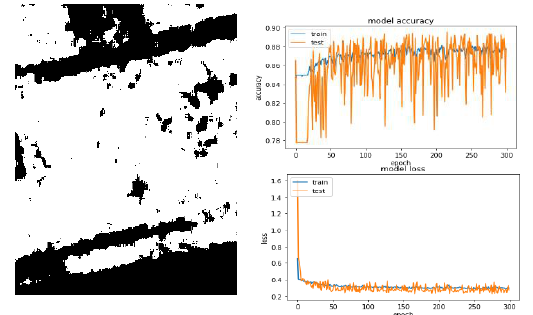
Figure 14 . Test 6 predictions: segmented image, model accuracy, model loss.